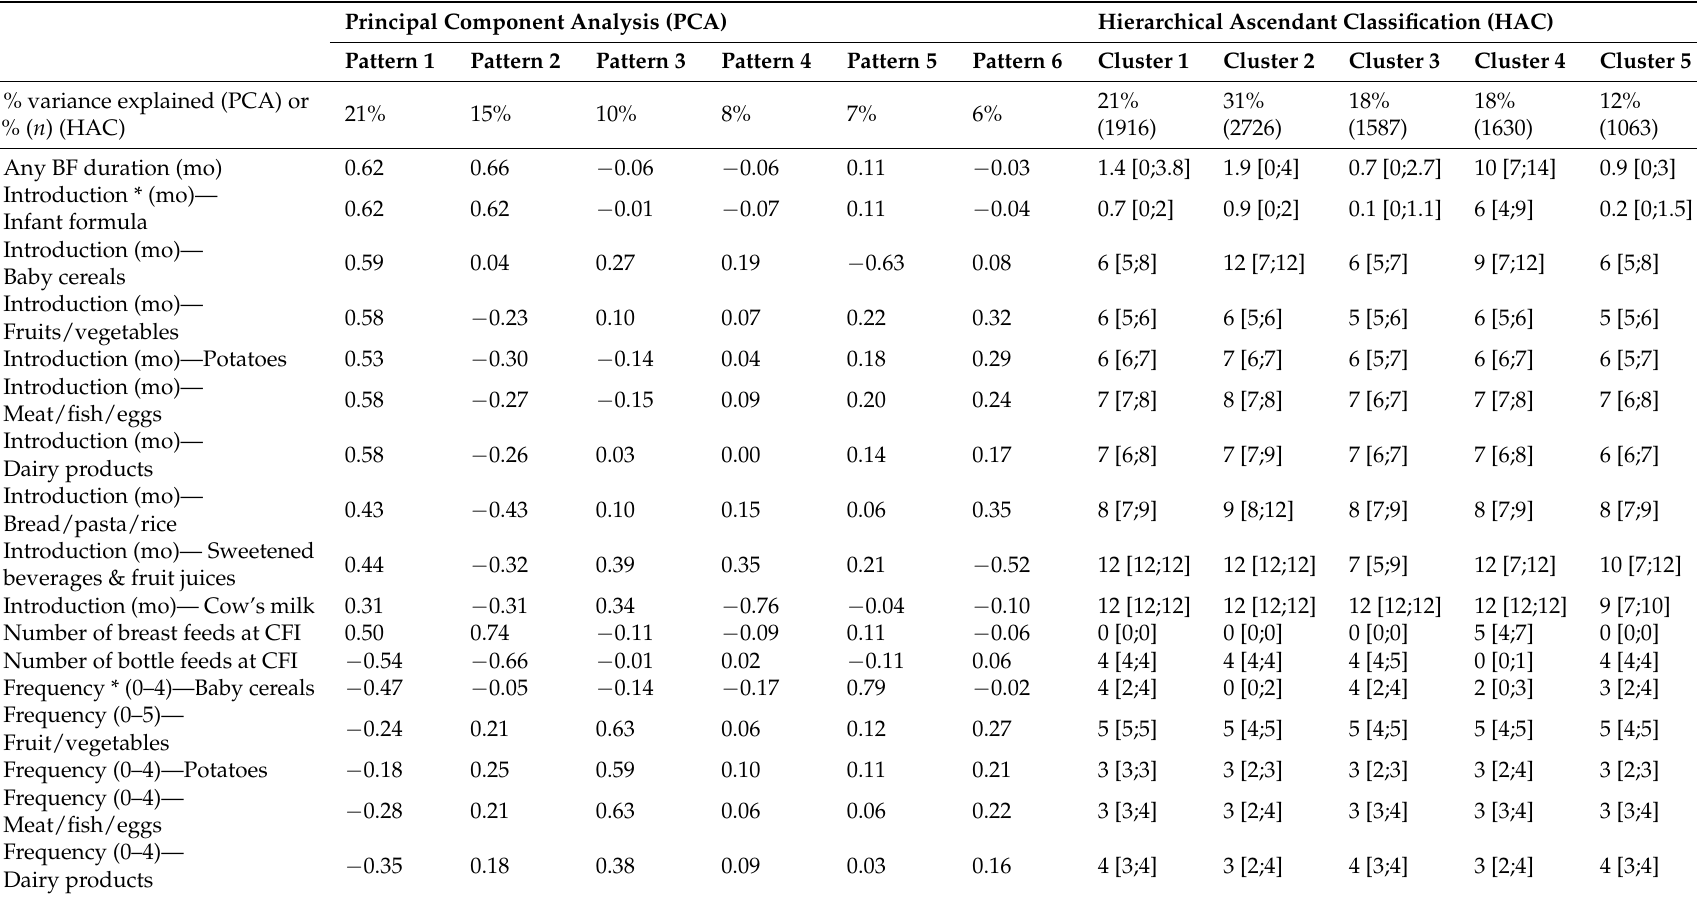
Table 1. Analysis of core variables (breast feeding (BF) and main food groups), Set A of variables ( n =